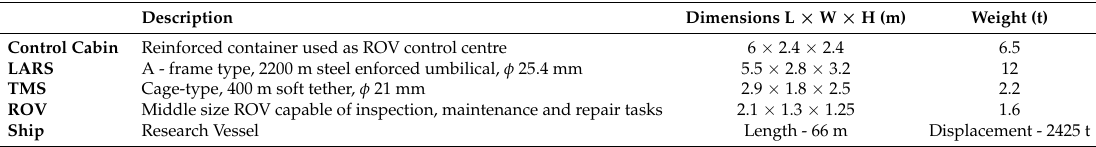
Figure 1. The system deployment during offshore trials in the North Atlantic Ocean in January 2019. The system consists of Launch and Recovery System (LARS), Tether management System (TMS), and work-class ROV Comanche. Table 1. Technical specification of the